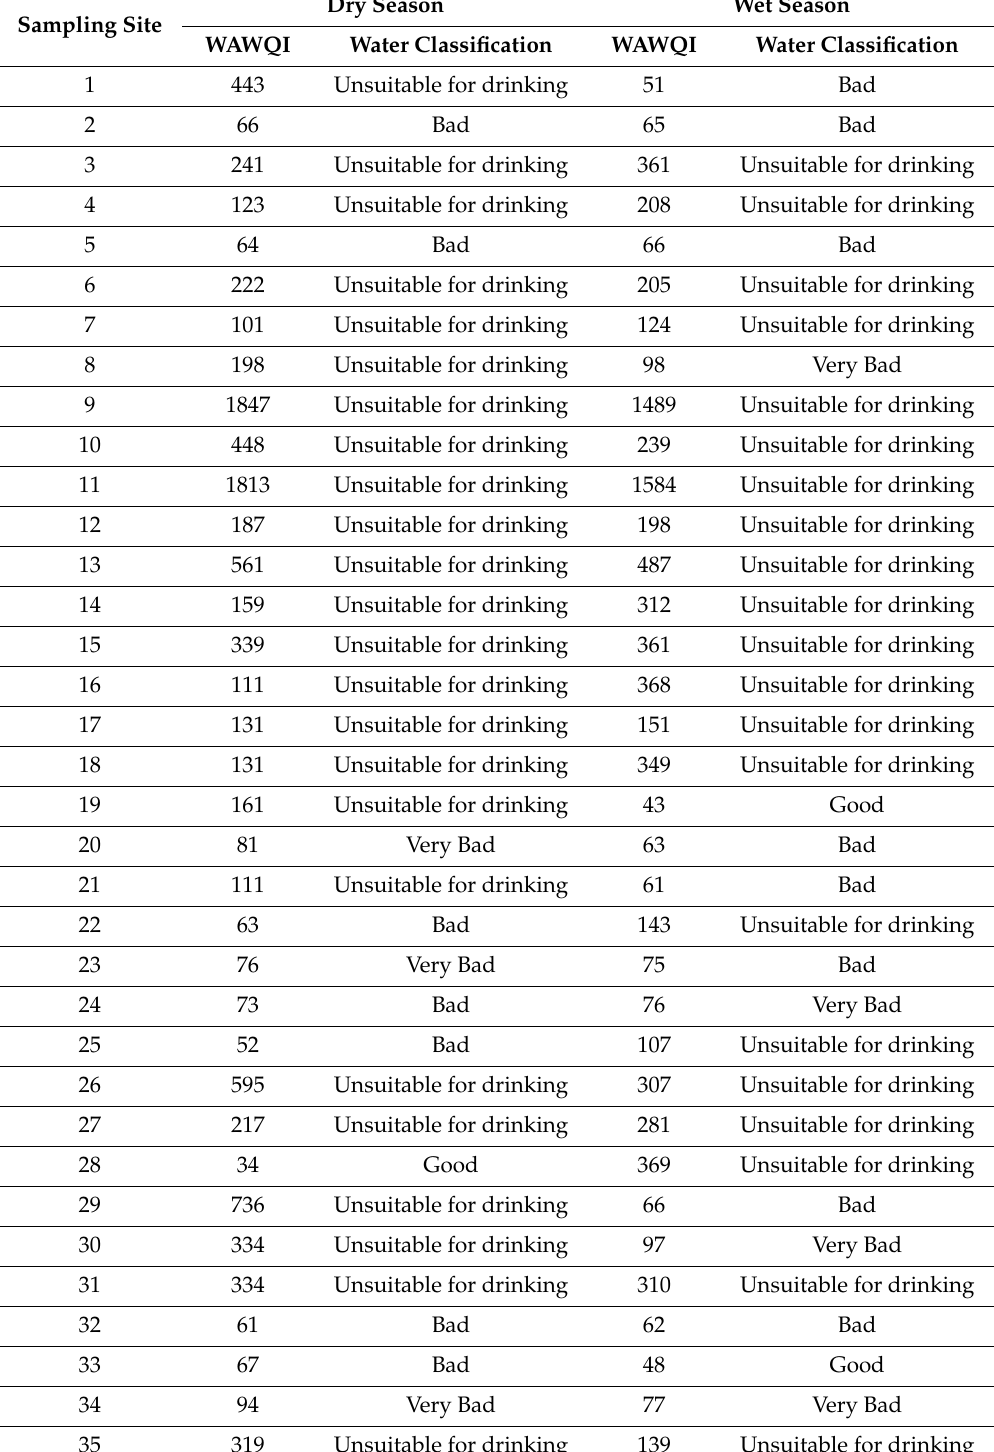
Table A1. The weighted arithmetic water quality index (WAWQI) at 40 sampling sites in the dry and wet season in